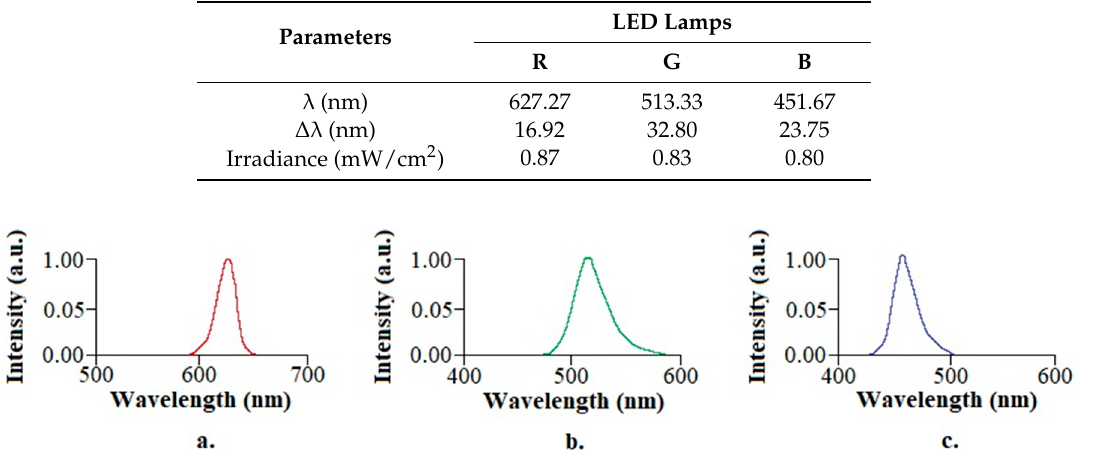
Table 1. Optical properties of light colors in light emitting diode (LED) lamps: red (R), green (G), and blue (B).